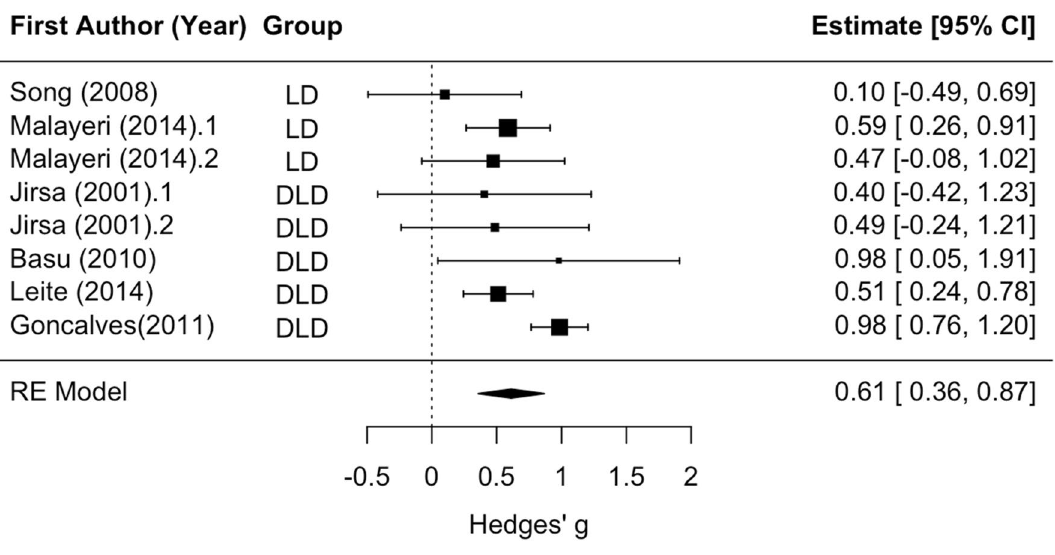
Figure 4. Wave III latency forest plot. Positive values for Hedges’ g indicate longer latency for the disorder group relative to controls. Rows with decimal points after the article year indicate multiple analyses from the same paper, and correspond to the row order of the analyses in the systematic review table in Supplement